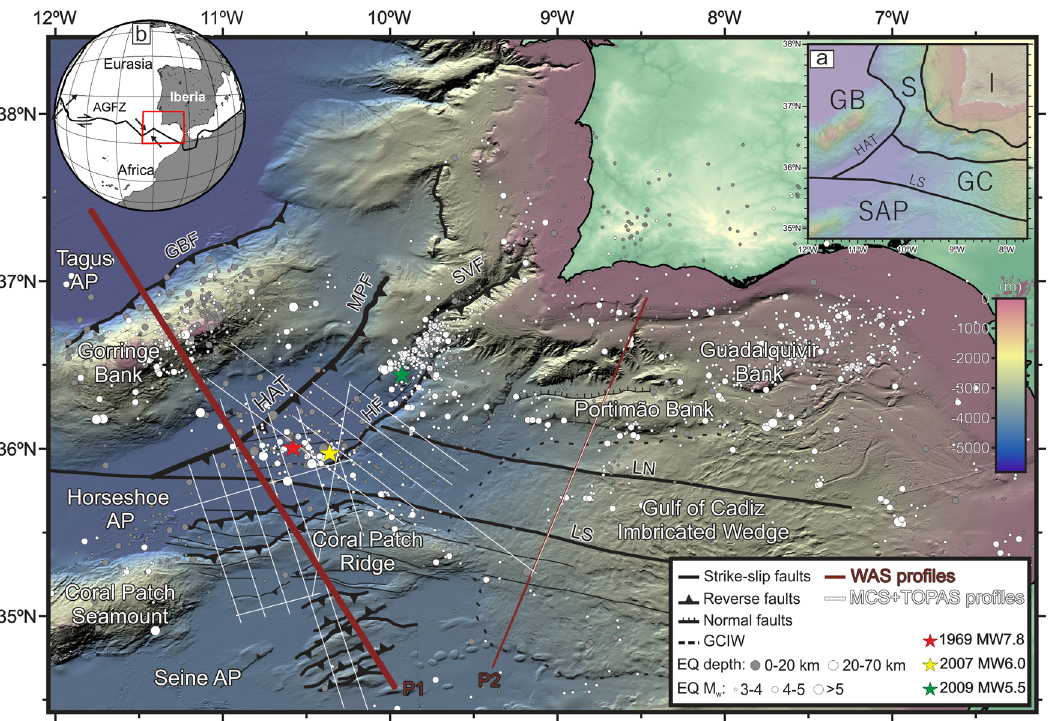
Fig. 1 Tectonic map offshore SW Iberia. Bathymetric map of the SW Iberian margin with the location of the main active tectonic structures 4 . The thick brown line is the wide-angle seismic pro fi le P1 30 along which the schematic cross-section of Fig. 2 has been drawn. The stars indicate the largest instrumental earthquakes that have occurred in the region (i.e., 1969 15 , 2007 5 , 2009 38 ; Supplementary Table 1). White and grey circles show epicentral locations of regional earthquakes with M w > 3 for the period 1960 – 2020 57 . a Map of the SW Iberian Margin Geological Domains 30 . b Global map including the major tectonic plates and boundaries. The red rectangle corresponds to the area depicted in this fi gure. AGFZ: Azores-Gibraltar Fault Zone; AP: Abyssal plain; GBF: Gorringe Bank Fault; HAT: Horseshoe Abyssal plain Thrust; HF: Horseshoe Fault; LN: Lineament North; LS: Lineament South; MPF: Marquês de Pombal Fault; SVF: São Vicente